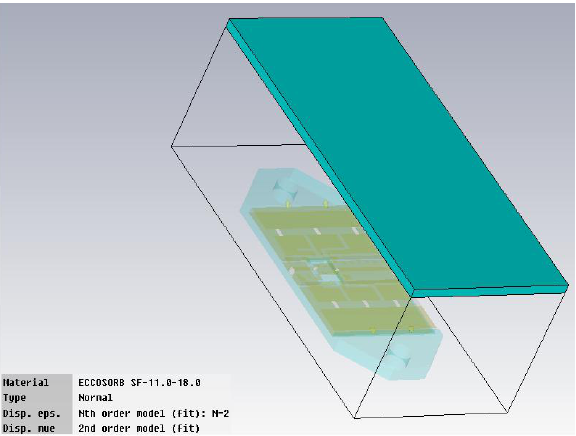
Figure 4: Absorber placed inside the lid that dilutes the cavity resonance effect.